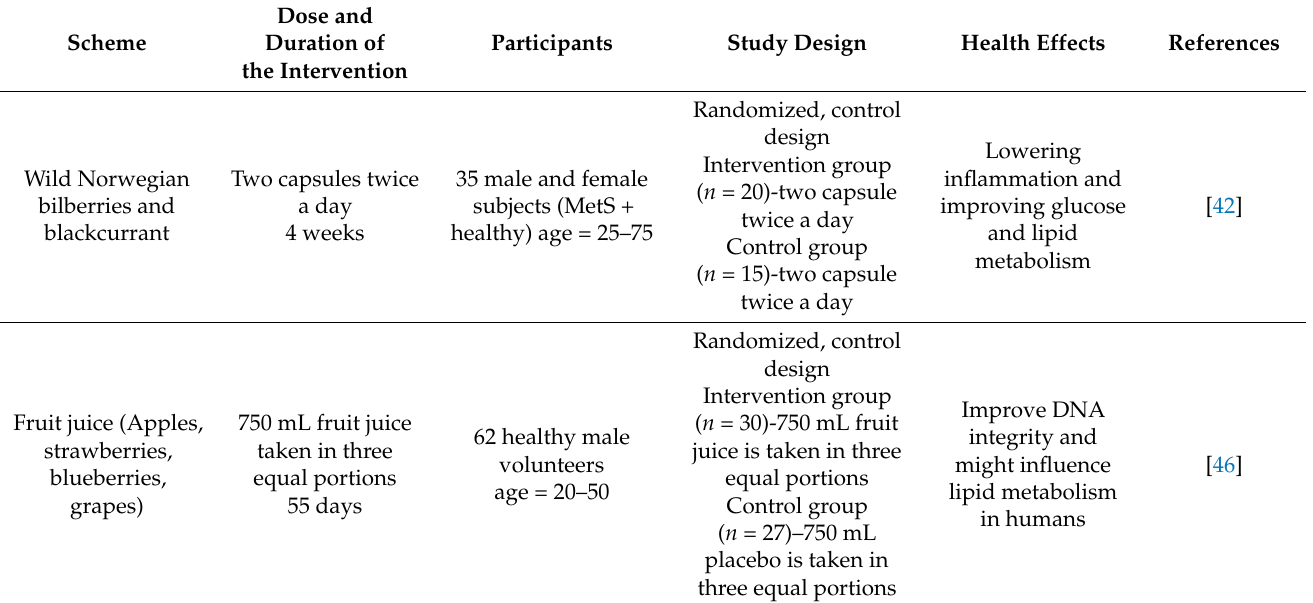
Table 2. Health Effects of